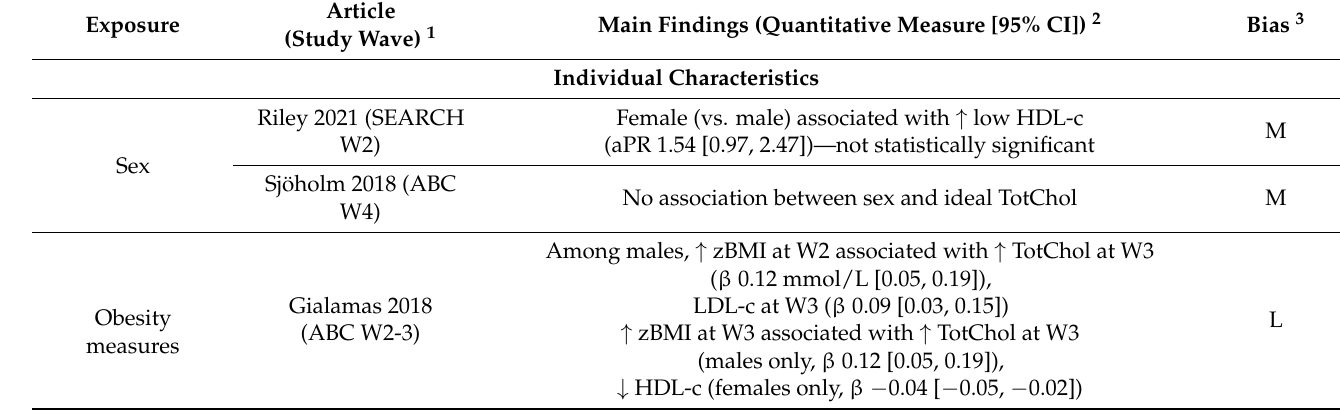
Table 7. Quantitative associations with lipid outcomes, arranged by exposure type and listed in order of lowest to highest risk of